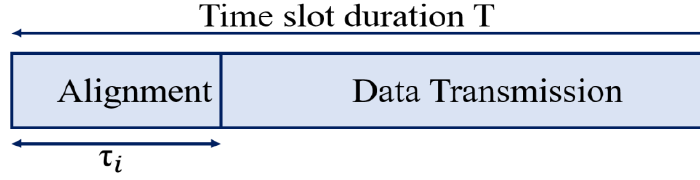
Figure 3. The segmentation of time slot for the ith link.